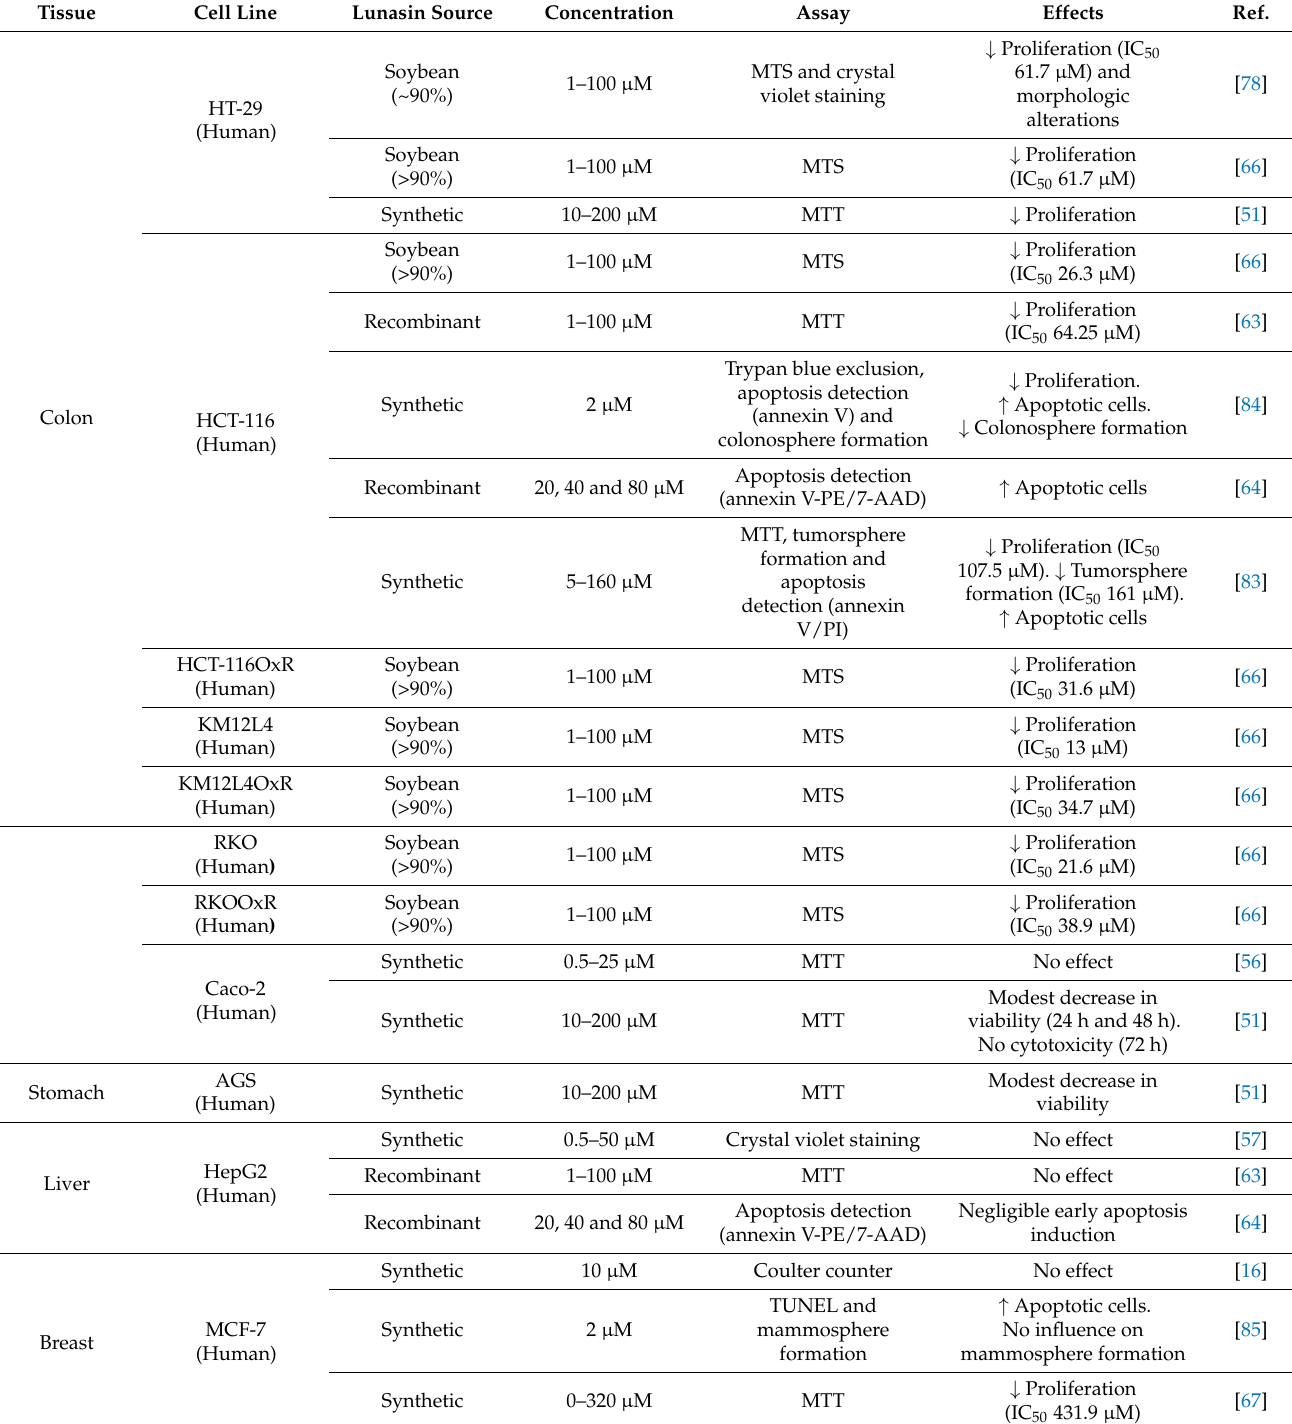
Table 3. Lunasin activity against cancer cell